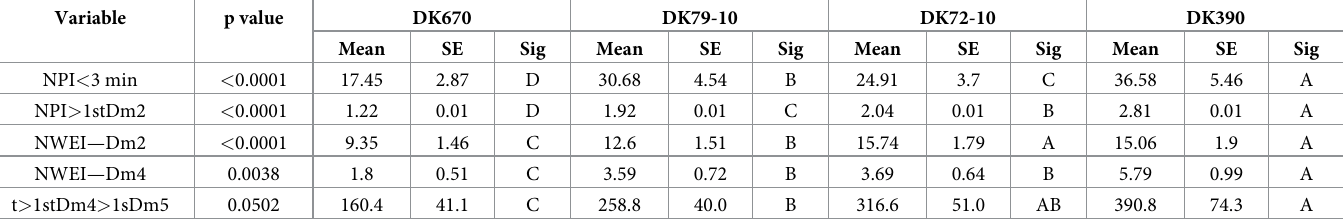
Table 2. Variables (Mean +/- Standard Error [SE]) of probing behavior of D . maidis insects with access to four maize hybrids. Values with the same significance (Sig) letter are not significantly different according to contrasts in the Fisher LSD test ( α = 0. 05). Variable